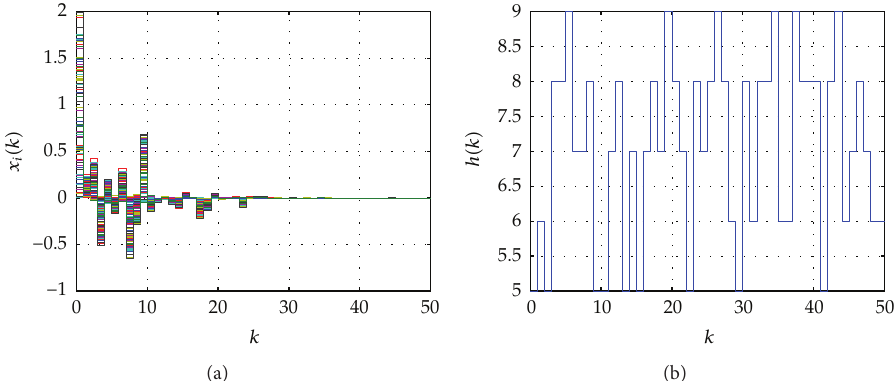
Figure 7: State responses and time-delay ℎ(𝑘) with C2-1 (Example 11).